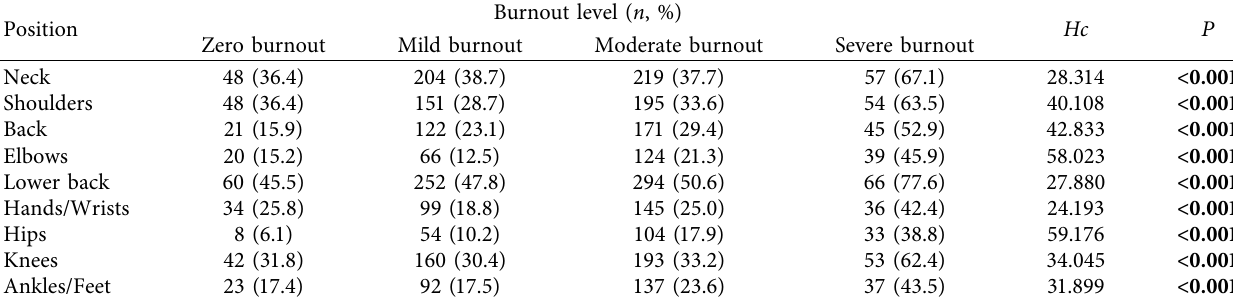
Table 4: The prevalence of WMSDs in 9 locations and the distribution of different levels of job burnout.